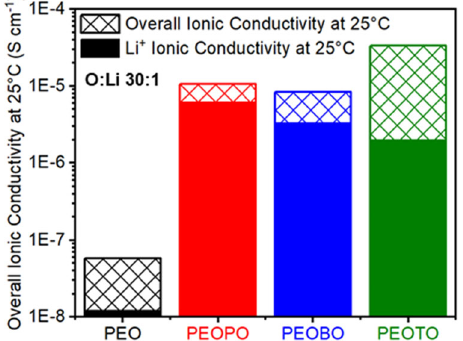
Fig. 5 Overall and Li + ionic conductivities at 25 °C. Overall ionic conductivity (solid bars, measured by NMR) and Li + ionic conductivity (patterned bars, measured electrochemically) at 25 °C for polyethylene oxide (PEO, black) and for copolymers containing 10 mol% of propylene oxide (PO, red), 1,2-butylene oxide (BO, blue), and methyl ether triethylene glycol glycidyl ether (TO,